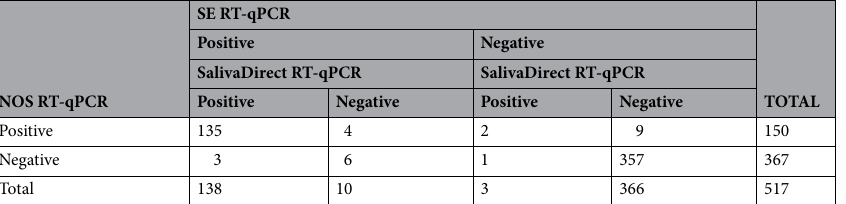
Table 1. Diagnostic agreement contingency table and estimates comparing SE and SalivaDirect RT-qPCR, as separate index tests, to NOS RT-qPCR for SARS-CoV-2 detection. NOS naso-oropharyngeal swab, RT‑qPCR reverse transcription quantitative/real-time polymerase chain reaction, SE saliva with RNA extraction.